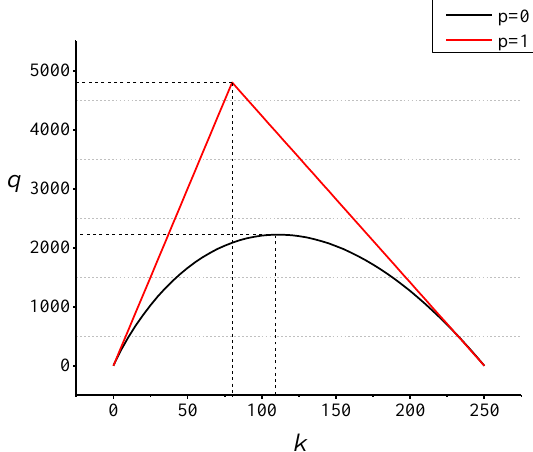
Figure 9. q - k graphs with p = 0 and p = 1. Figure 9. q-k graphs with p = 0 and p = 1. Figure 9. q-k graphs with p = 0 and p = 1.